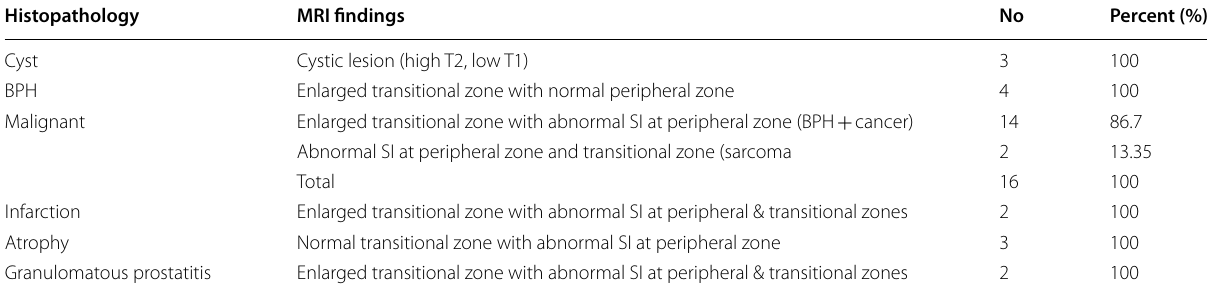
Table 2 Conventional MRI compared with histopathology results Histopathology